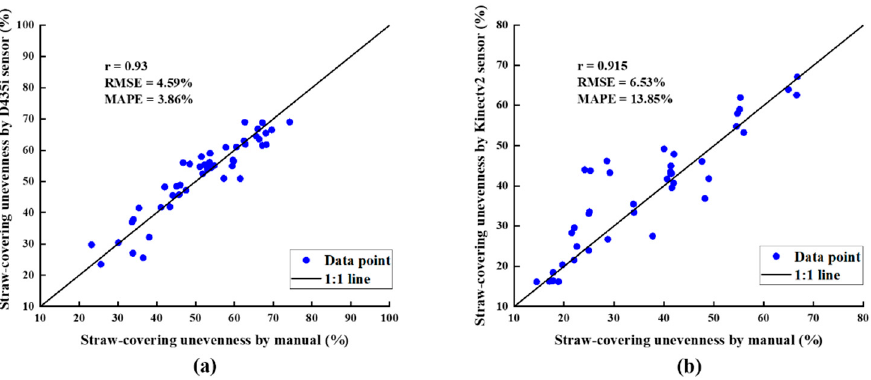
Figure 5. The correlation coefficient plots of unevenness by manual ( a ) versus RGB-D ( b ) sensors. In addition, this method may provide some reference to depth acquisition and the detection of vegetation coverage. Compared to the two RGB-D sensors, without extra power supply and lighter weight, D435i has the advantage to be installed on the no-tillage planter or other platforms. Both the RGB-D sensors are affected by ambient light. Lidar, as a common sensor to detect depth, is less affected by ambient light, but it costs higher than RGB-D sensor. In the future, it is necessary to conduct real-time detection of straw coverage unevenness under different crop straw, different ambient light with different